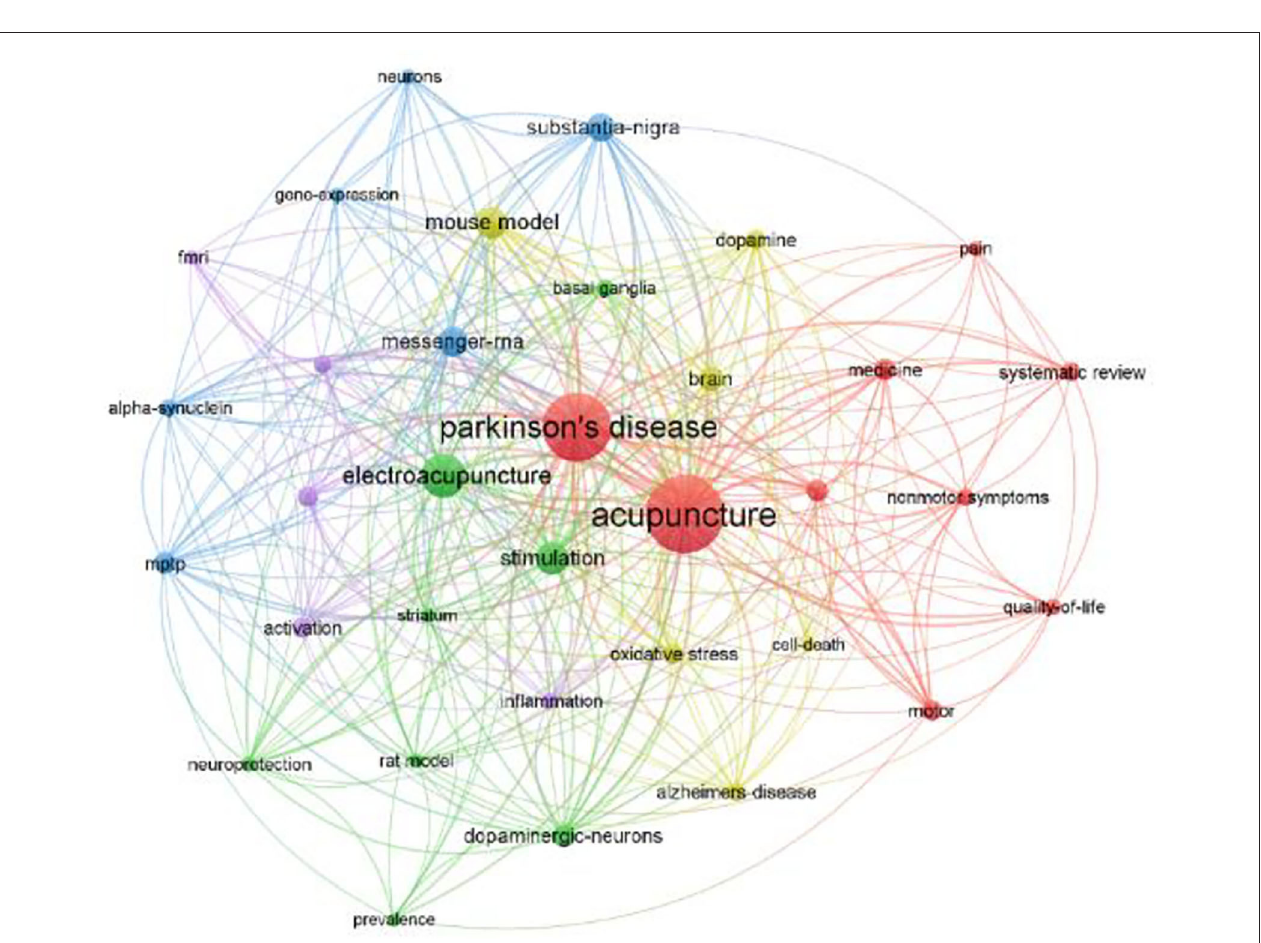
FIGURE 5 | Network map of clustering keywords from VOSviewer. Each node represents a keyword and the size of the nodes represents the frequency of occurrences. The color of the nodes distinguishes the cluster of the keyword.